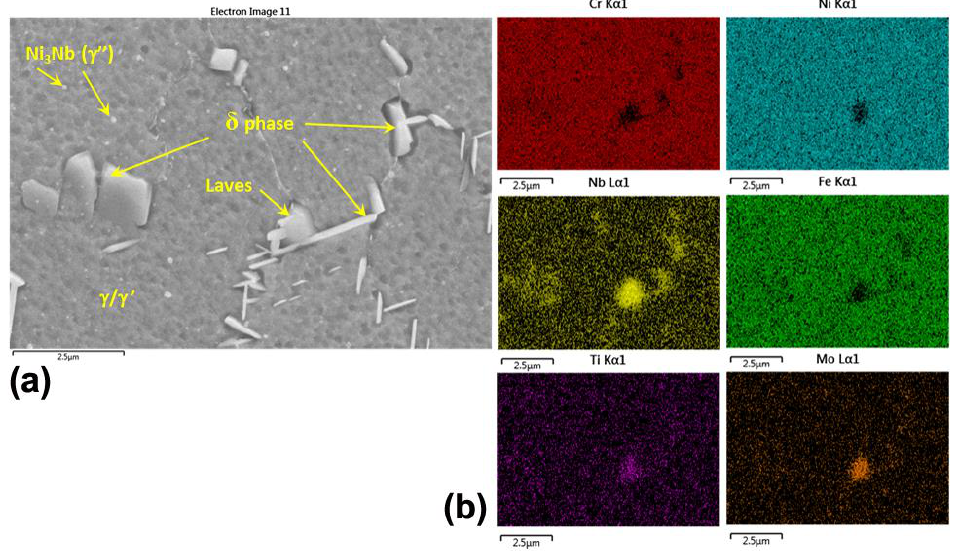
Figure 11. FESEM micrograph for IN718 alloy with standard heat treatment—TT0 (polished sample, SE mode). ( a ): SLM Y-axis sample and ( b ): the respective x-ray elemental maps through EDS.